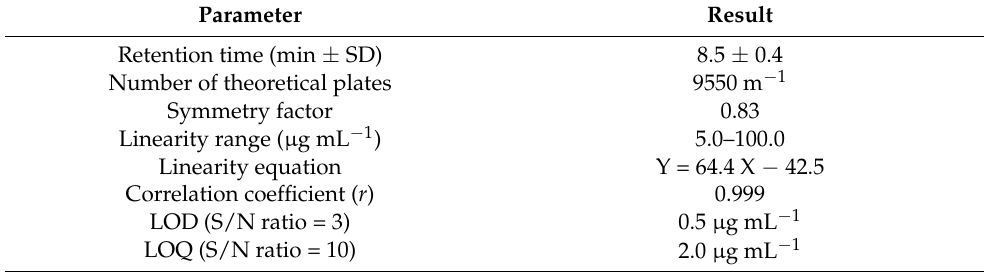
Table 1. Linearity and regression results for determination of RDS using the proposed LC